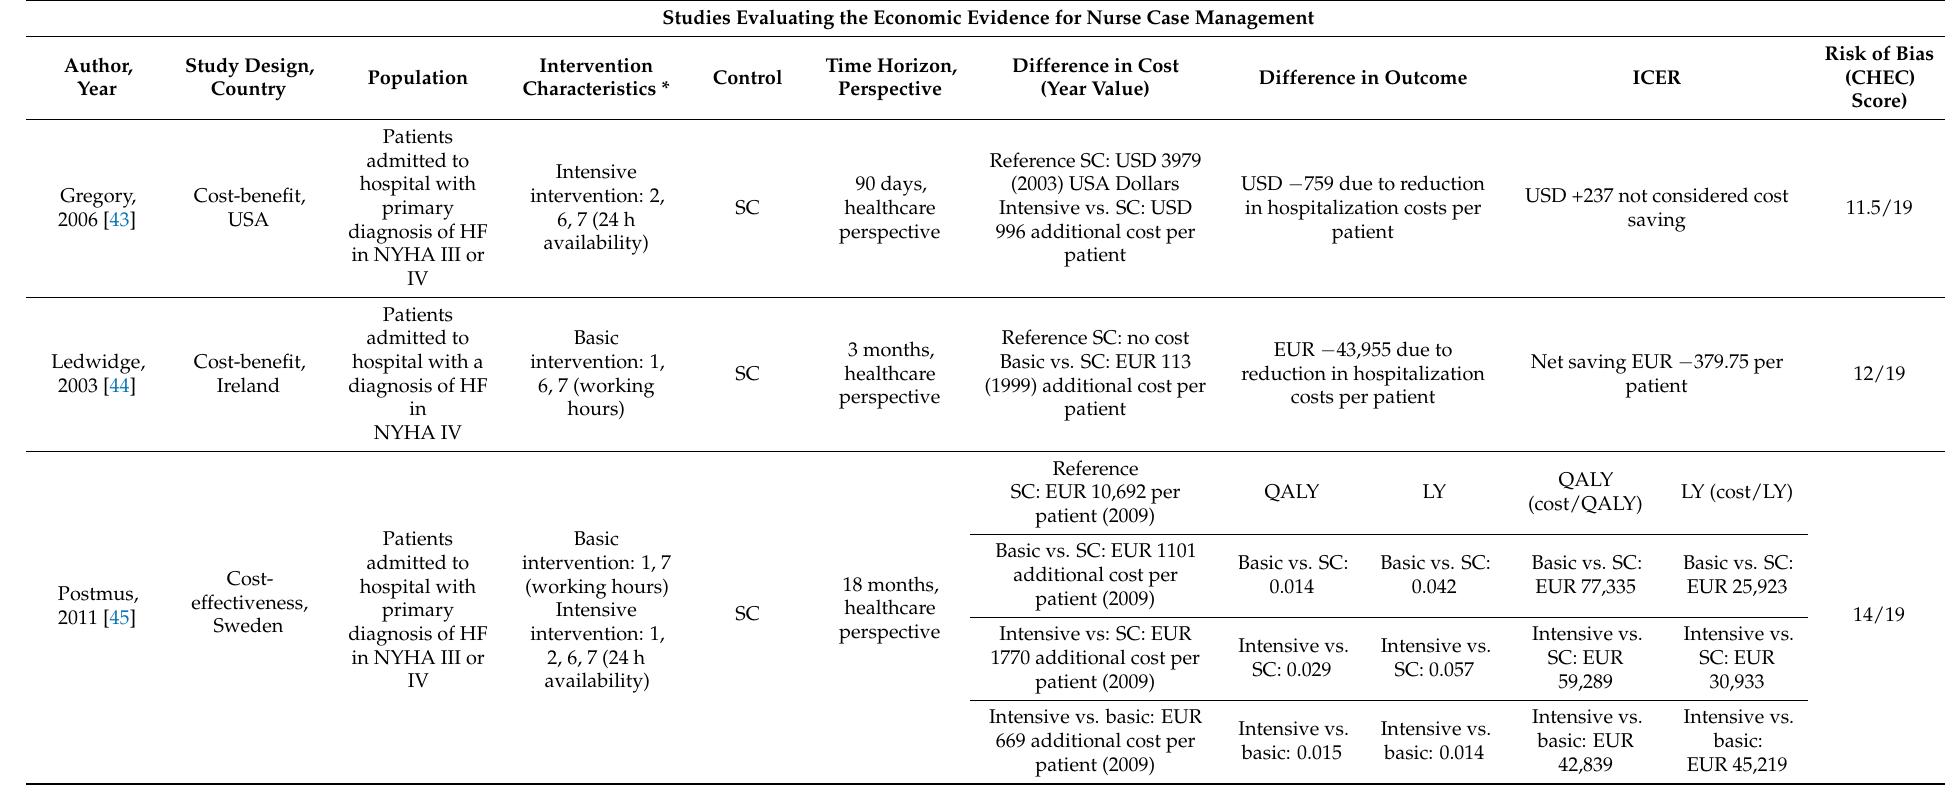
Table 2. Characteristics and summary of results of the included studies for the economic evaluation of case management in advanced heart failure